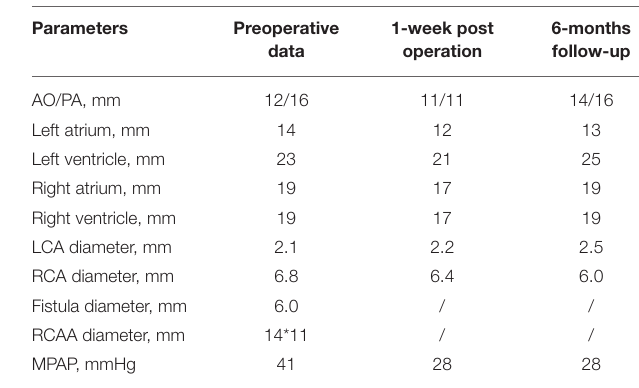
TABLE 1 | Echocardiography parameters before and after surgical